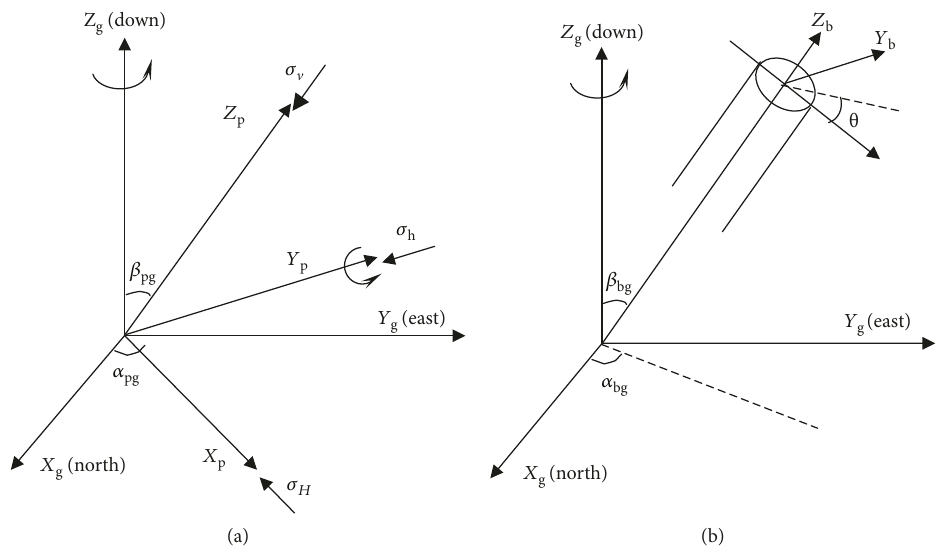
Figure 1: Coordinate system transformation. (a) The principal stress coordinate system transforms to the geographic coordinate system. (b) The geographic coordinate system transforms to the borehole coordinate